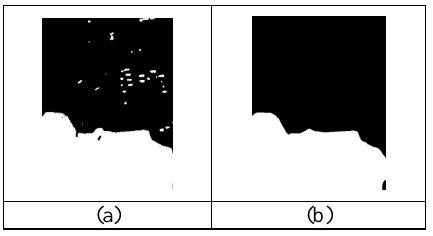
Figure 5. An example of shadow removal result (a) before